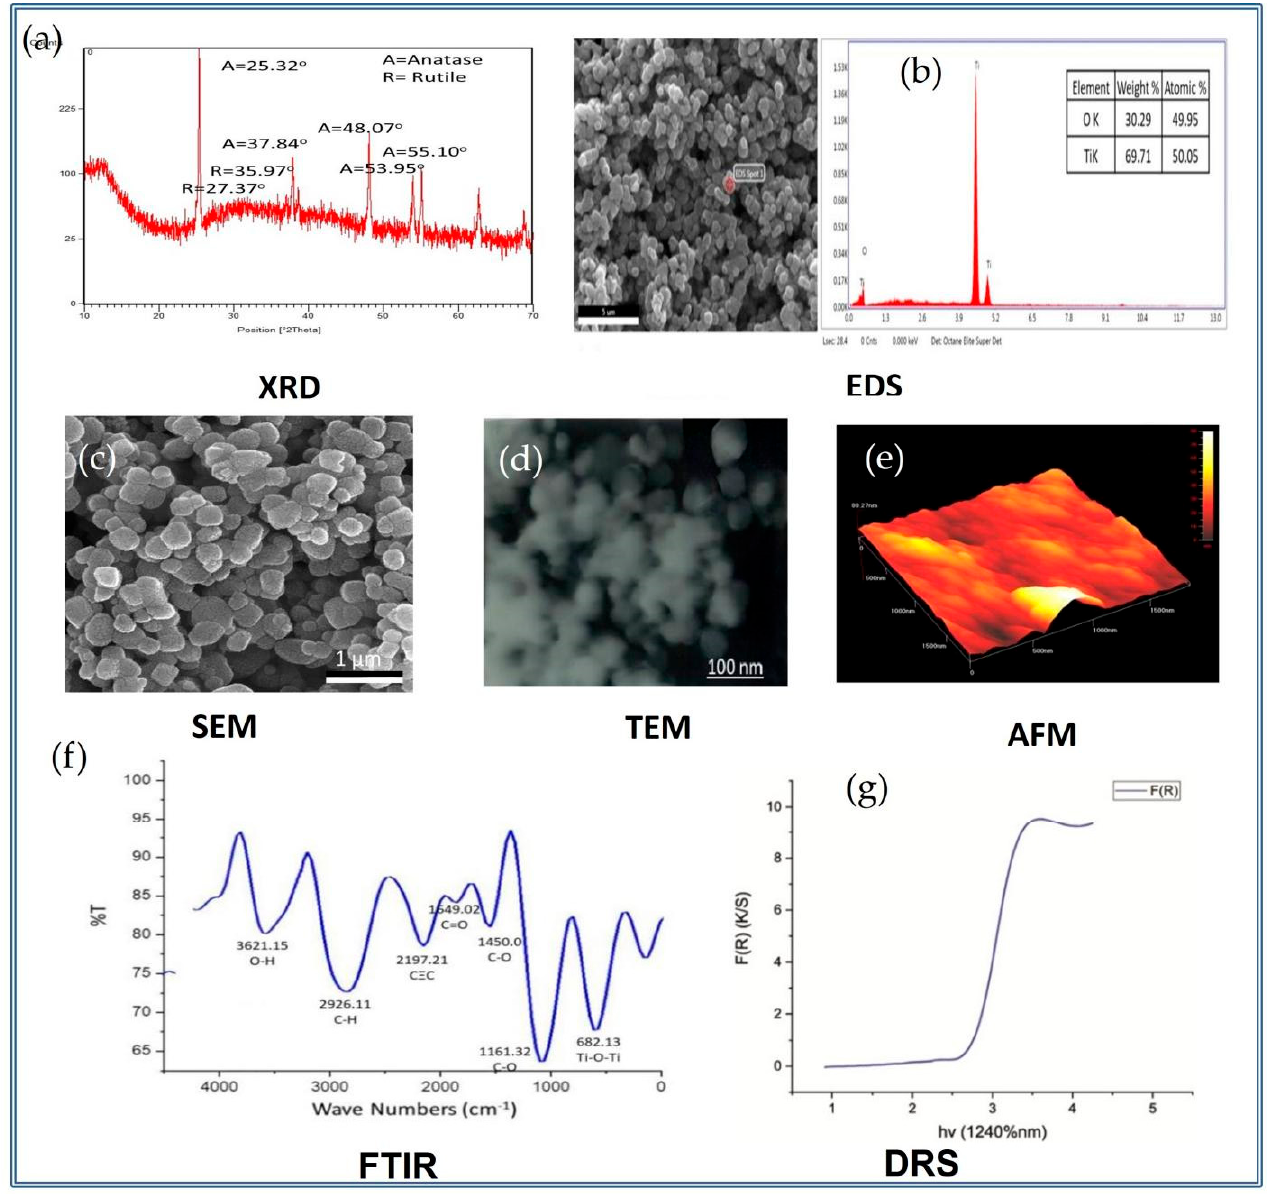
Figure 5. Different characterization techniques utilized by TiO 2 NPs for their particular fea- tures: ( a ) X-ray diffraction pattern spectroscopy (XRD) for investigating the size, shape, and phase form; ( b ) energy-dispersive X-ray spectroscopy (EDS) for investigating the elemental composition; ( c ) scanning electron microscope (SEM) for investigating the size, shape, and surface morphology; ( d ) transmission electron microscope (TEM) for investigating the size and shape; ( e ) atomic force microscope (AFM) for investigating the surface roughness and topography; ( f ) Fourier transform infrared spectroscope (FTIR) for investigating the functional groups; and ( g ) diffuse reflectance spectroscope (DRS) for investigating the size, shape, and crystal type [79].